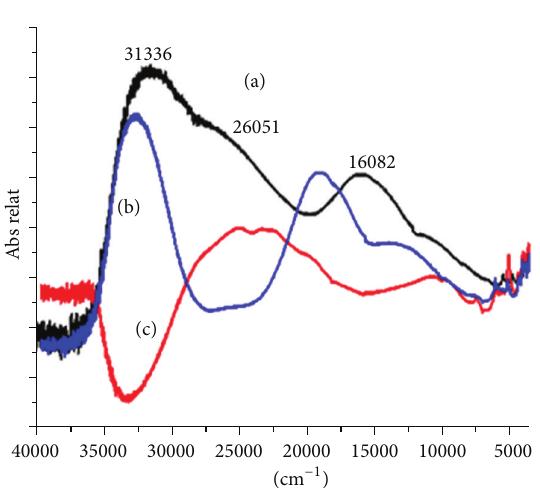
Figure 2: Electronic spectra for (a) [Cu 2 Co( S,S (+)cpse) 3 (H 2 O) 3 ] ⋅ 4H 2 O ( 1 ), (b) [Cu( S,S (+)cps) 2 ] ⋅ 2H 2 O, and (c) [Co( S,S (+)cps) 2 ] ⋅ 2H 2 O synthetized previously.